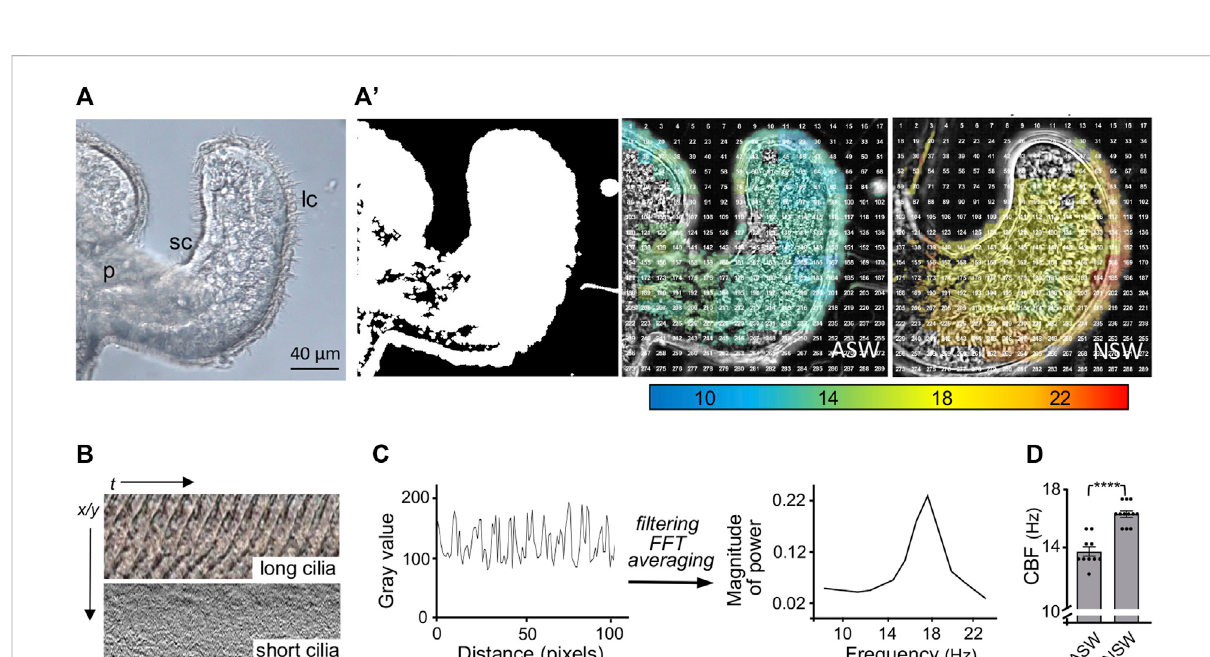
FIGURE 2 Analyses of the ciliated fi eld that potentiates host colonization by the bacterial symbiont. (A) A still image from a high-speed video (×40, DIC, 1,000 frames/sec) of one half of the hatchling squid light organ, showing the long (lc) and short (sc) cilia; p, pore. (A 9 ) Left, a MATLAB algorithm detects areas of motion (white); middle and right, speed of ciliary beat, calculated using fast Fourier transform (FFT) of each window, at 30 min post hatching of the host animal into either arti fi cial (ASW) or natural (NSW) seawater. (B) Kymographs showing the changes in gray values over time oftheciliarybeatinthelong(metachronallybeating)andshort(randomlybeating)cilia,respectively; t ,time; x/y =pixellocation. (C) Periodicchanges ingray valueover distance (pixels),which representstime correspondingto thebeat pattern ofthemetachronally beating, long cilia.